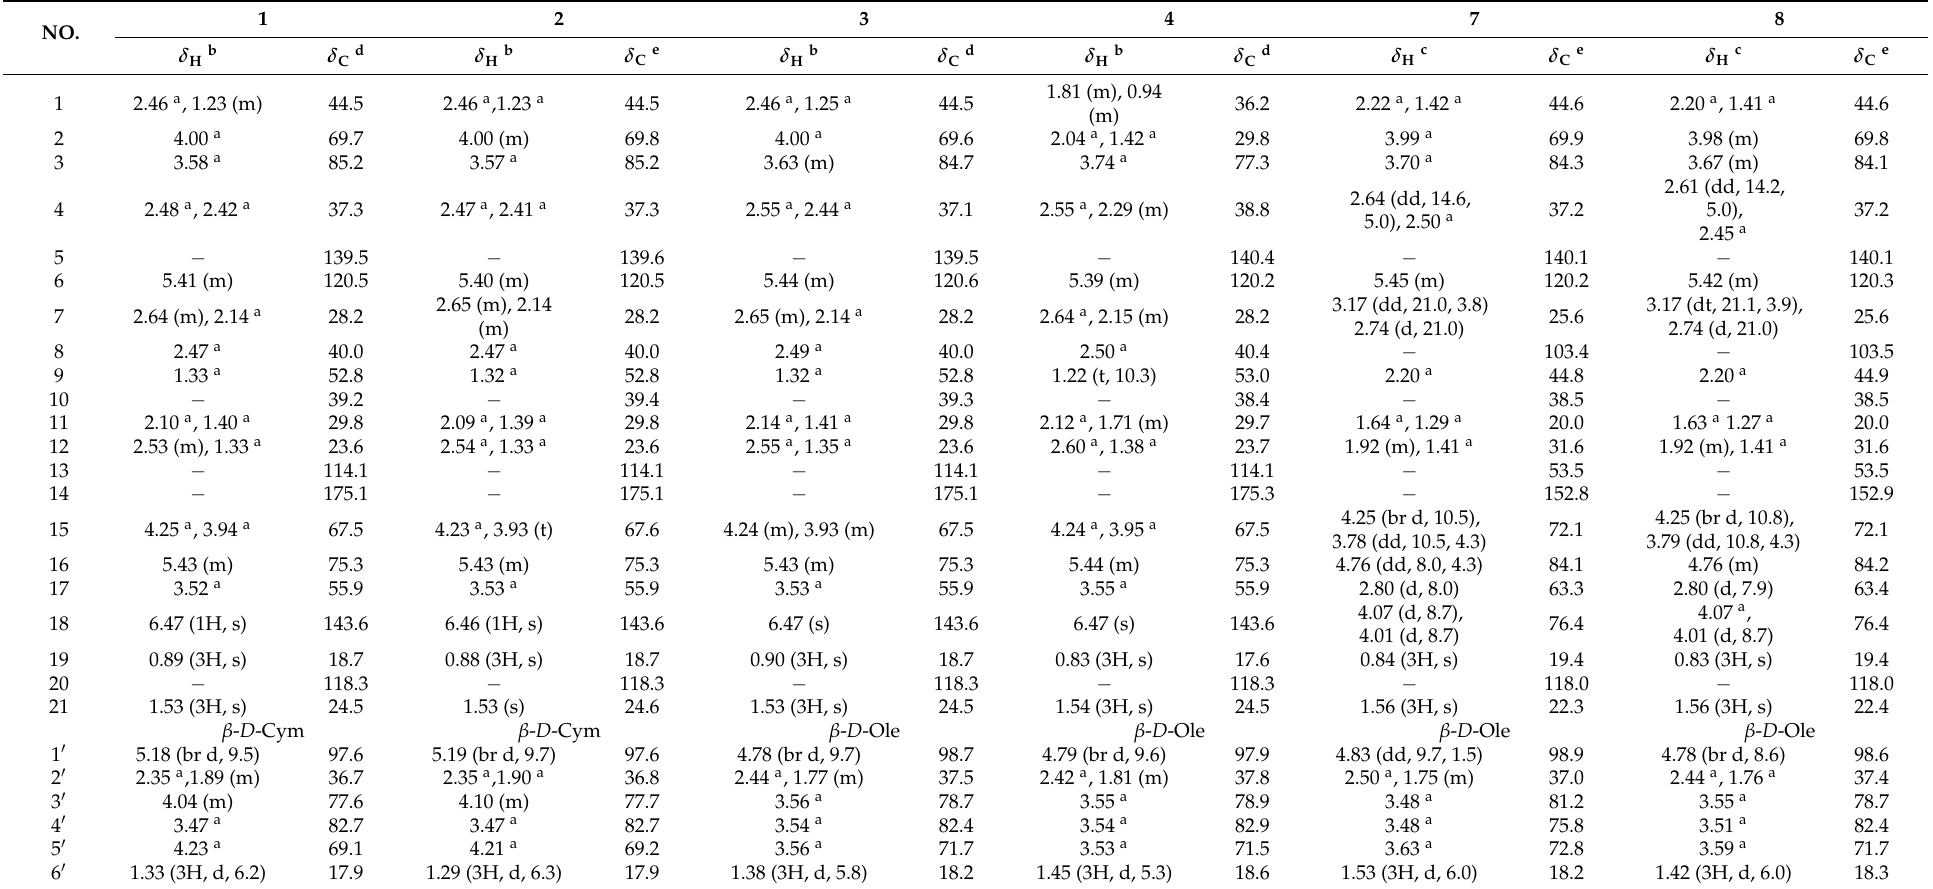
Table 1. 1 H and 13 C NMR data in C 5 D 5 N for compounds 1 – 5 , 7 – 8